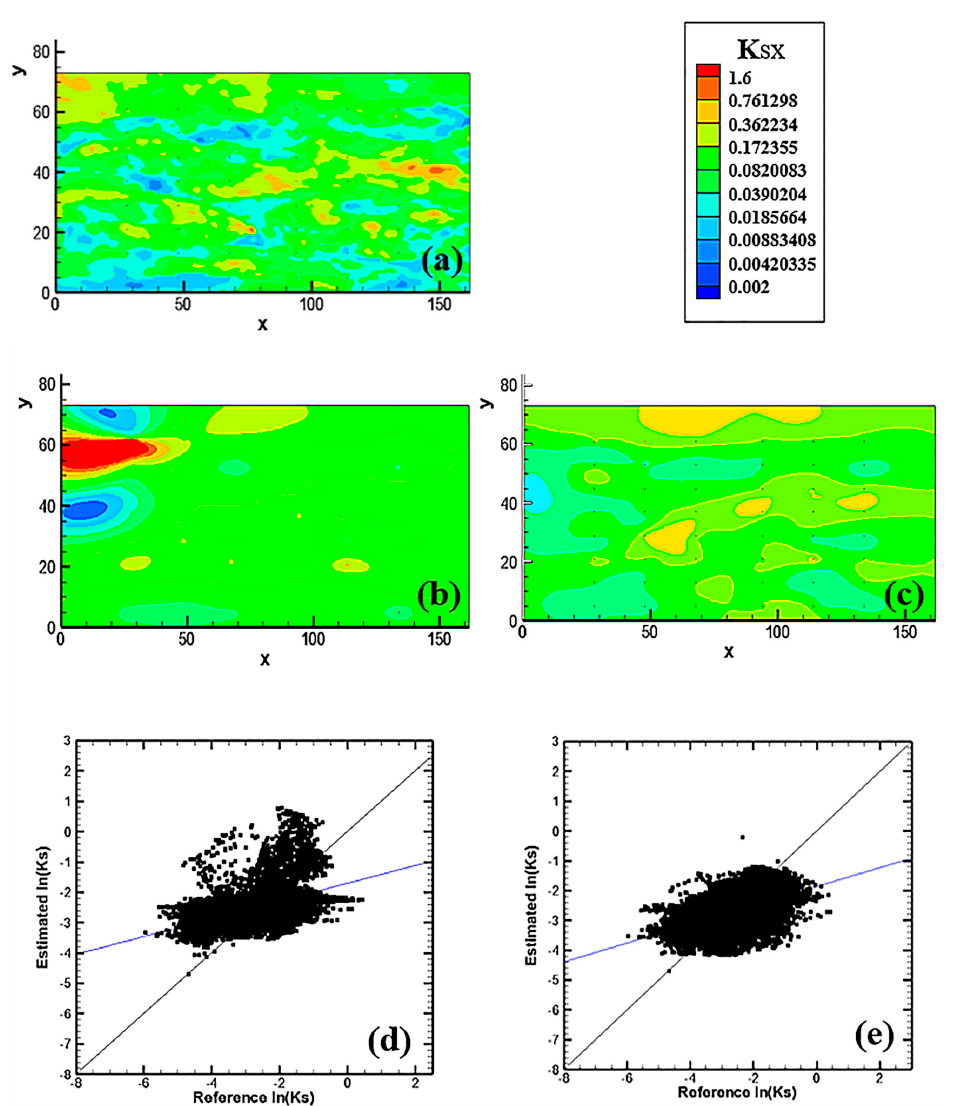
Figure 3. Spatial distribution of different K field: ( a ) the reference K field; ( b ) the kriging-estimated K field without a priori geological information; ( c ) the kriging-estimated K field with a priori information. Scatter plots of the fitting curves for LnK by kriging method: ( d ) without a priori geological information; ( e ) with a priori geological information. The units of axis are cm/s.